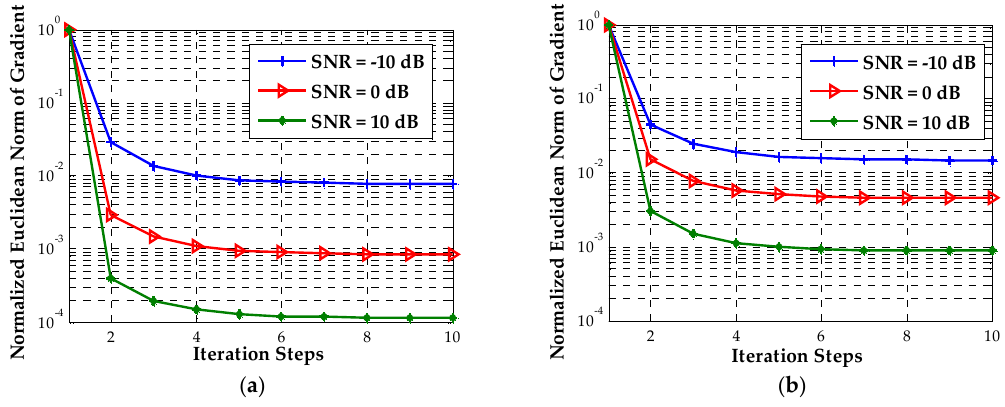
Figure 3. The normalized Euclidean norm of gradient versus iteration steps. ( a ) Source 1; ( b ) Source 2.